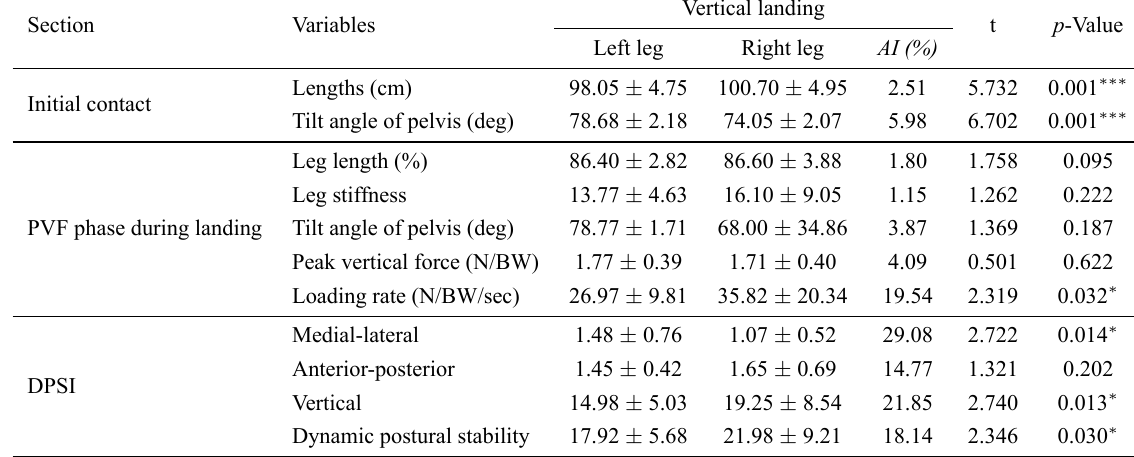
Fig. 5. Medial-lateral and anterior-posterior stability index for each subjects. Table 1. Result of kinetic variables between bilateral leg during vertical landing.